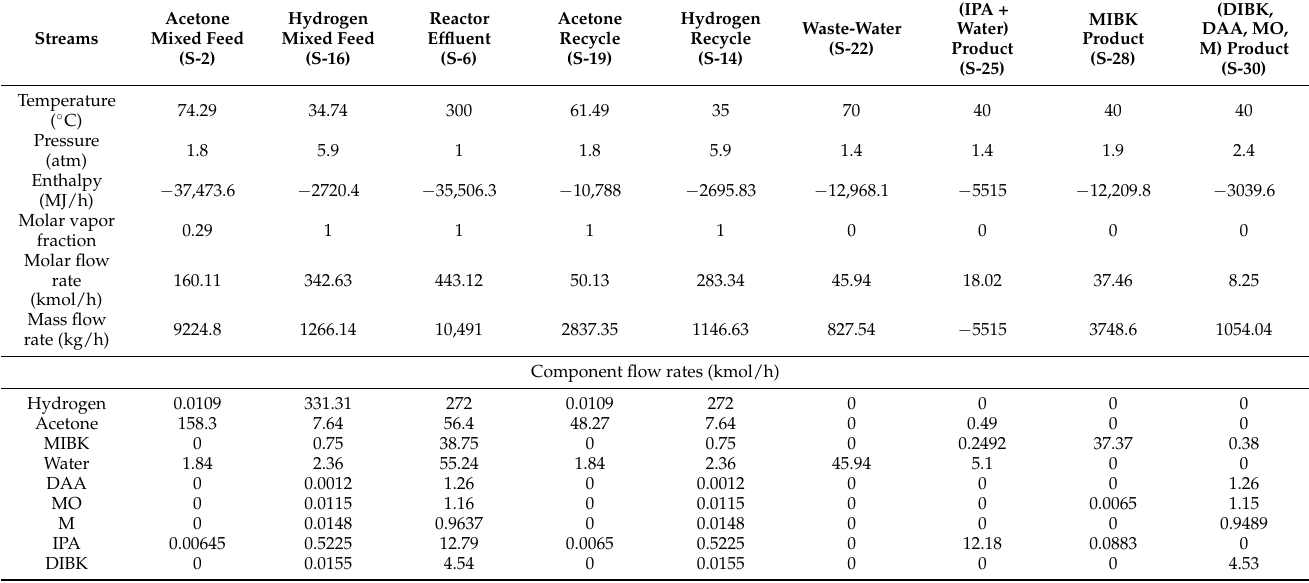
Table 2. Material balance of key streams for the developed MIBK